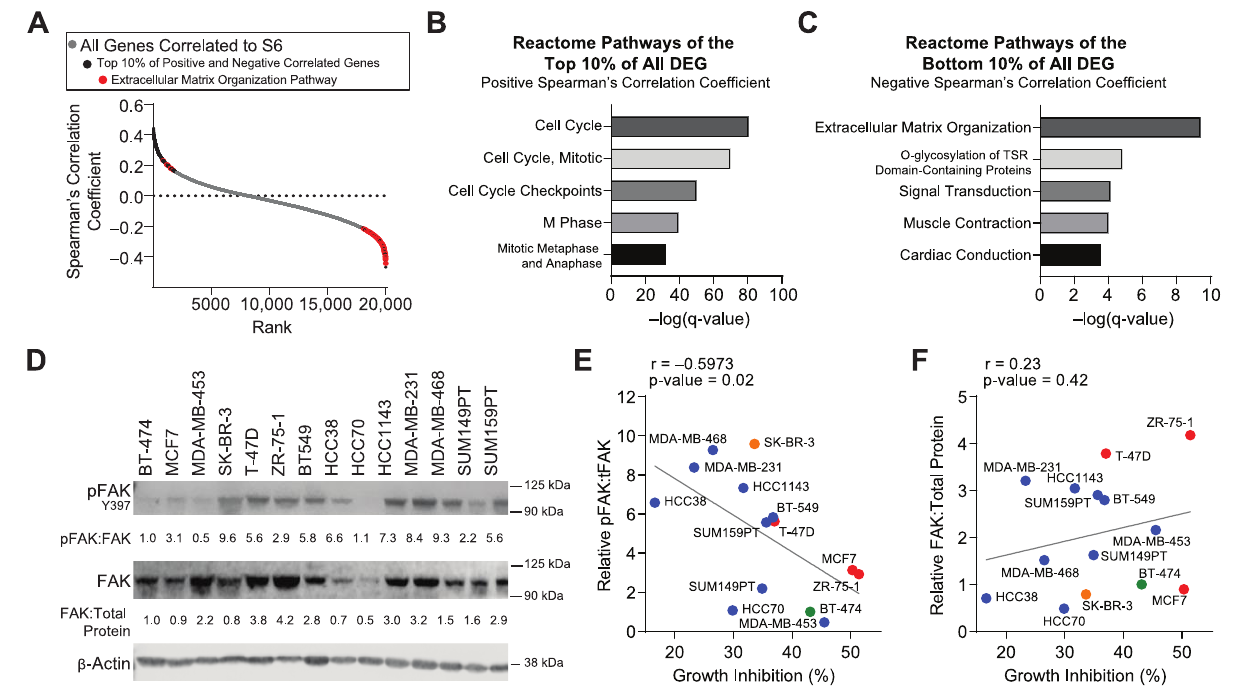
Figure 2. The extracellular matrix and FAK activation are associated with resistance to mTORC1 inhibitors. ( A ) Ranking of genes by their Spearman’s correlation coefficient to S6 (RPPA) from 876 breast cancer patients in the TCGA, Pan-Cancer Atlas dataset. Red dots are genes that com- prise the ECM remodeling Reactome pathway. Reactome pathway enrichment analysis of the ( B ) top and ( C ) bottom 10% of genes correlated with S6 protein in breast cancer. ( D ) Protein ex- pression of phosphorylated FAK (pFAK Y397), total FAK (FAK), and β -actin (loading control) in 14 breast cancer cell lines. Quantitation of pFAK to FAK and FAK to total protein (Supplementary Figure S2) are shown. ( E ) Scatterplot illustrating the correlation between the pFAK:FAK ratio to ra- pamycin growth inhibition. r = Pearson’s correlation coefficient, two-tailed p -value. Colors represent breast cancer receptor-defined subtypes: red, ER+/PR+/HER2-, green, ER+/PR+/HER2+, orange, ER-/PR-/HER2+, blue, ER-/PR-/HER2-. ( F ) Scatterplot illustrating the correlation between relative rapamycin growth inhibition and the calculated FAK/total protein